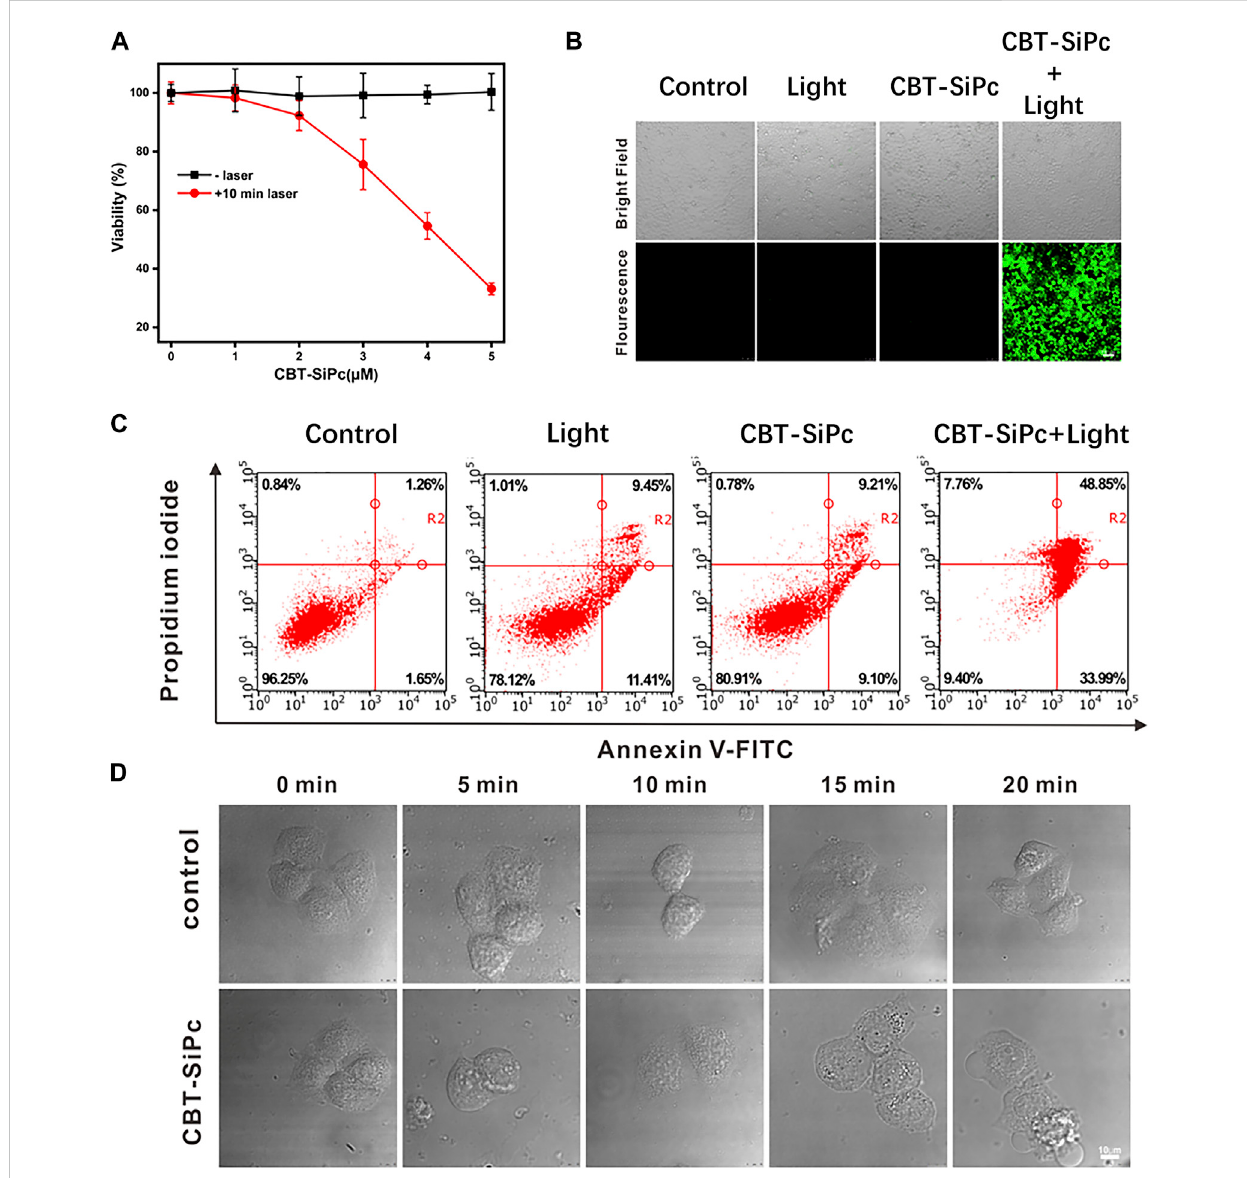
FIGURE 4 In vitro photodynamic therapy ef fi cacy of CBT-SiPc against MCF-7 breast cancer cells. (A) Concentration-dependent phototoxicity of CBT-SiPc against MCF-7 cells before and after irradiation (671 nm, 100 mW/cm 2 , 10 min). (B) Confocal fl uorescence images of intracellular ROS generation by CBT-SiPc (671 nm, 100 mW/cm 2 , 10 min) in MCF-7 cells before and after irradiation using CM-H 2 DCFDA as the probe ( λ ex = 488 nm; λ em = 490 – 590 nm). (C) Flow cytometry analysis of CBT-SiPc-mediated, PDT-induced MCF-7 cells apoptosis/necrosis mechanism before and after irradiation (671 nm, 100 mW/cm 2 , 10 min). (D) Morphological changes of MCF-7 cells (co-incubated with CBT-SiPc) by confocal microscopy upon laser irradiation (671 nm, 100 mW/cm 2 and 0, 5, 10, 15, and 20 min,